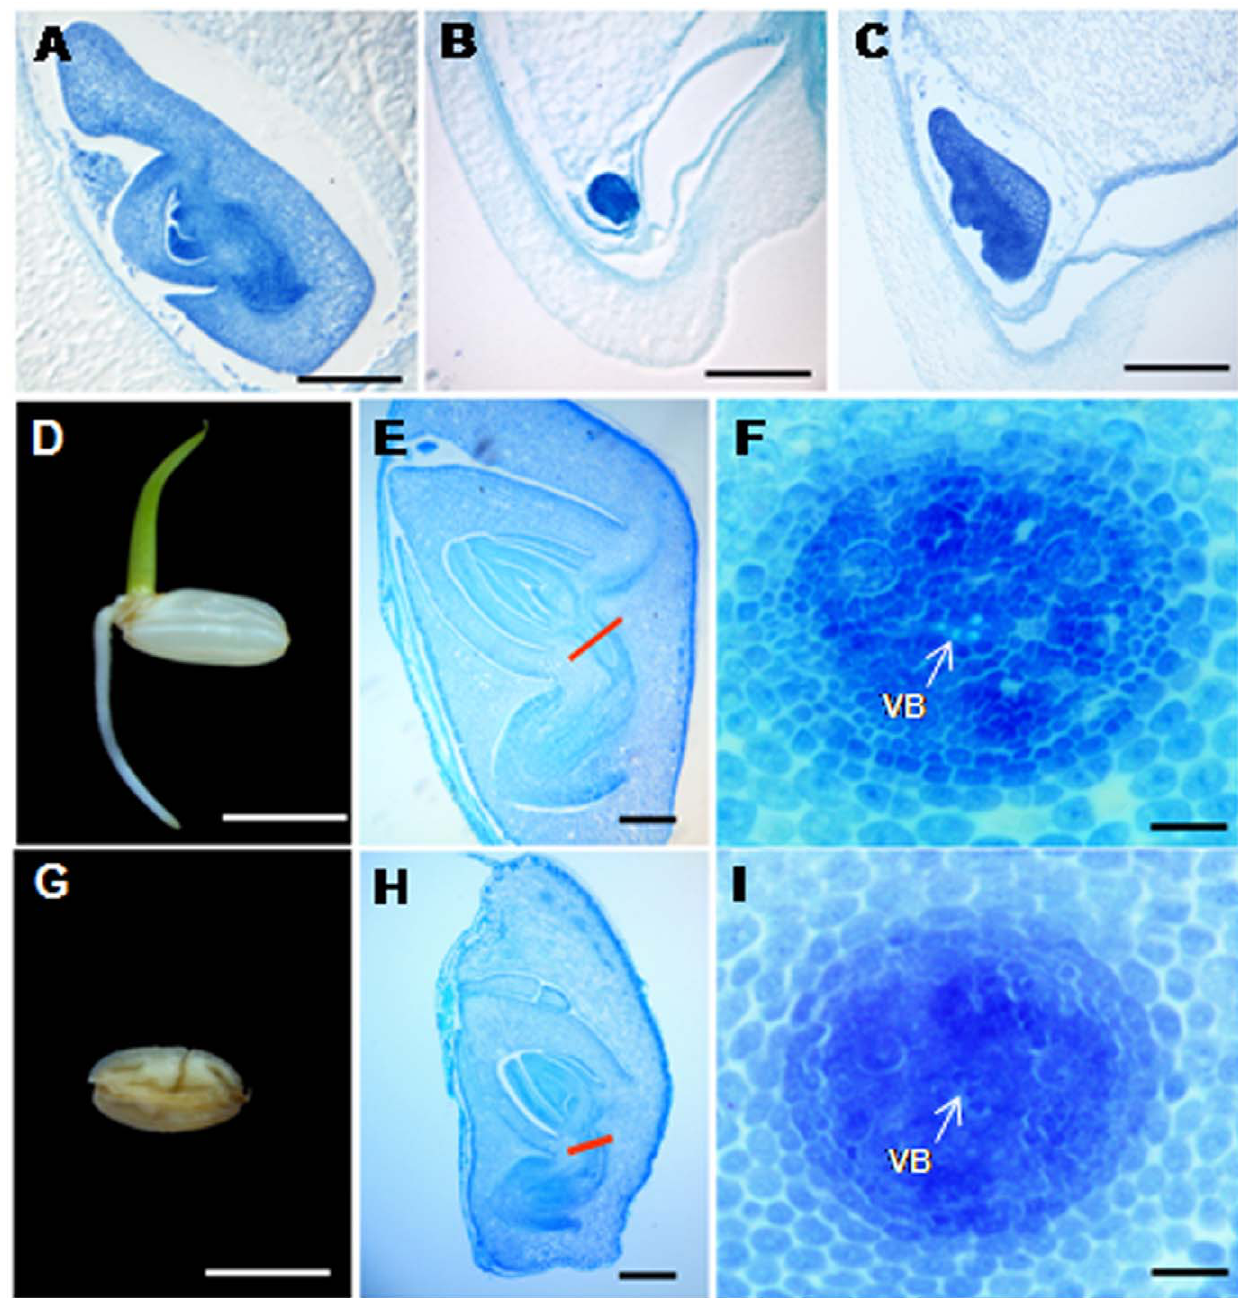
Figure 5. Histological structure of embryo and germination of mature seeds. (A). Longitudinal sections of control embryo at 7DAP. (B, C) Longitudinal sections of embryo of s-seeds (B) and m-seeds (C) at 7 DAP, respectively. (D). The normally germinated seed of control plant. (E). Longitudinal sections of the mature embryo in control seed. The red line referred to the position of vascular bundle. (F). Magnifying observation of cross sections from the red line marked parts in (E). The arrow showed the clear vascular bundle. (G). The m-seeds failed to germinate. (H). Longitudinal sections of the mature embryo in m-seeds. (I). Magnifying observation of cross sections from the red line marked parts in (H). No obvious vascular bundles were observed at the arrow referred place. VB, vascular bundles. Bars=20 m m in (A–C), 5 mm in (D) and (G), 0.2 mm in (E) and (H), 20 m m in (F) and (I).